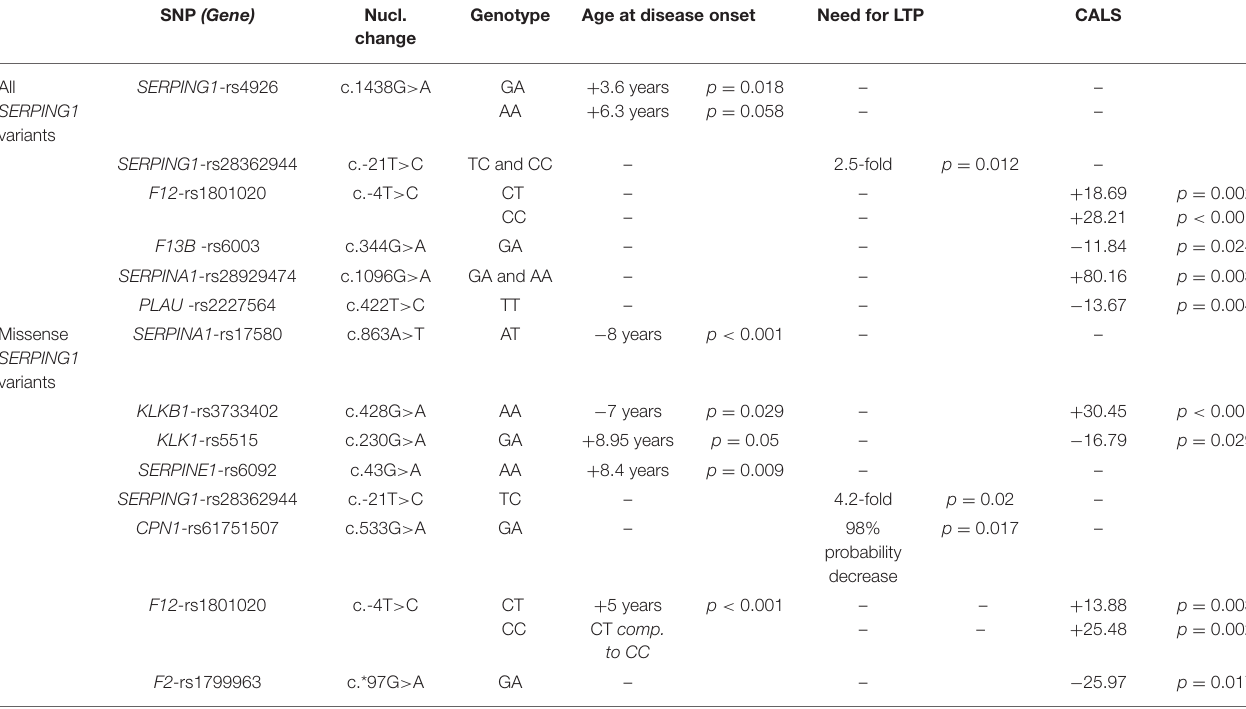
TABLE 3 | Summary of the correlations of common functional variants with patients’ phenotype – age at disease onset, need for LTP, CALS severity score. SNP